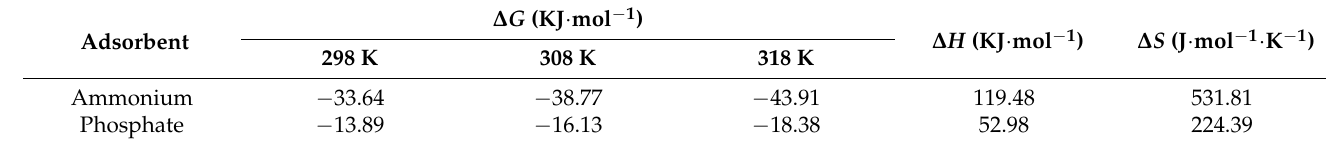
Table 5. Thermodynamic parameters.